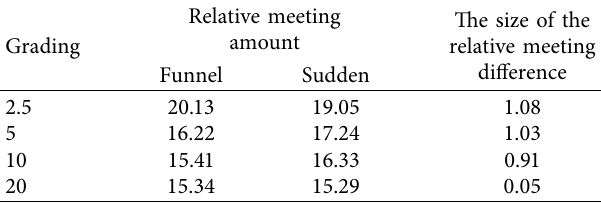
The size of the relative